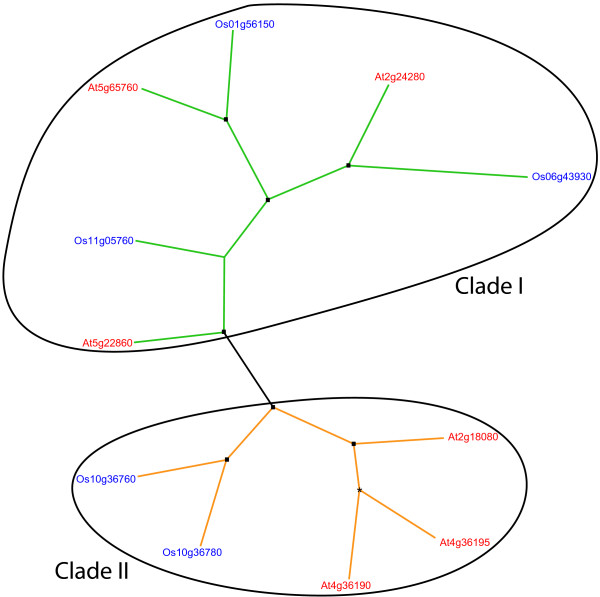
Unrooted N-J tree computed from multiple sequence alignments of Arabidopsis (red) and rice (blue) family S28 protease domains. S28-like protease domains were aligned using ClustalW [95] program and the alignments were exported to Phylip package [96] for representing the Neighbor-Joining tree (see methods). The colors represent the two evolutionary clades identified in the analysis (see text for details). Clade I is represented in Orange, Clade II is shaded green. For clarity, bootstrap values were replaced with symbols representing bootstrap percentages >50%. Bootstrap values between 50–60% are represented by an asterix, circles represent bootstrap values from 60%–80% while bootstrap values >80% are represented by rectangles. Gene names correspond to those in Additional files 1 and 2. For brevity, rice gene names have been shortened to OsXXg##### instead of LOC_OsXXg#####, XX referring to chromosome 1–12 and a 5 digit number assigned to each gene.